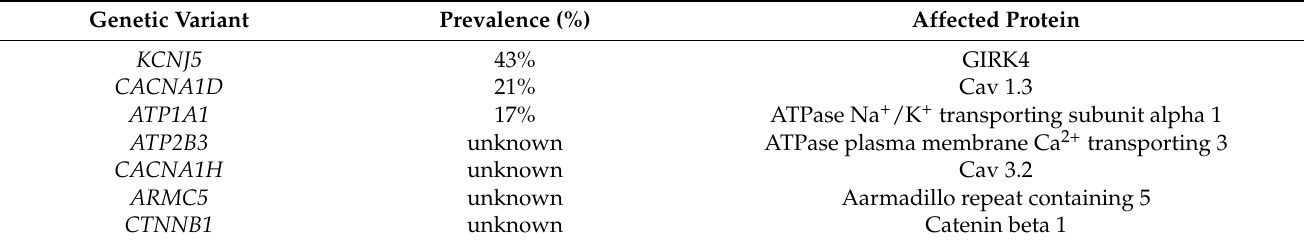
Table 3. Most common mutations detected in APA and